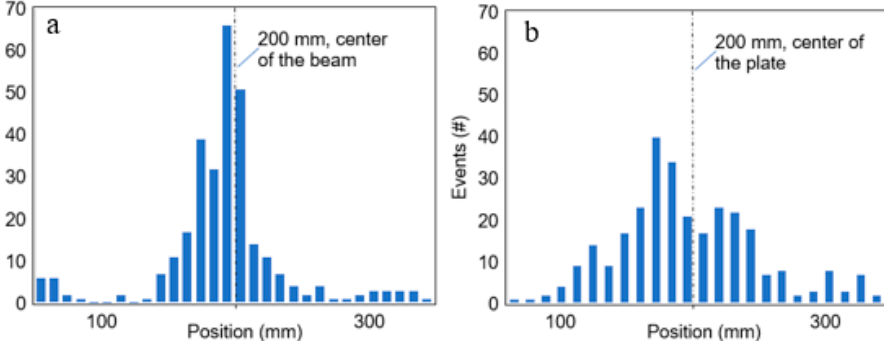
Figure 12. Linear AE localization distribution for the first 300 events of the ( a ) beam and ( b ) plate specimens.